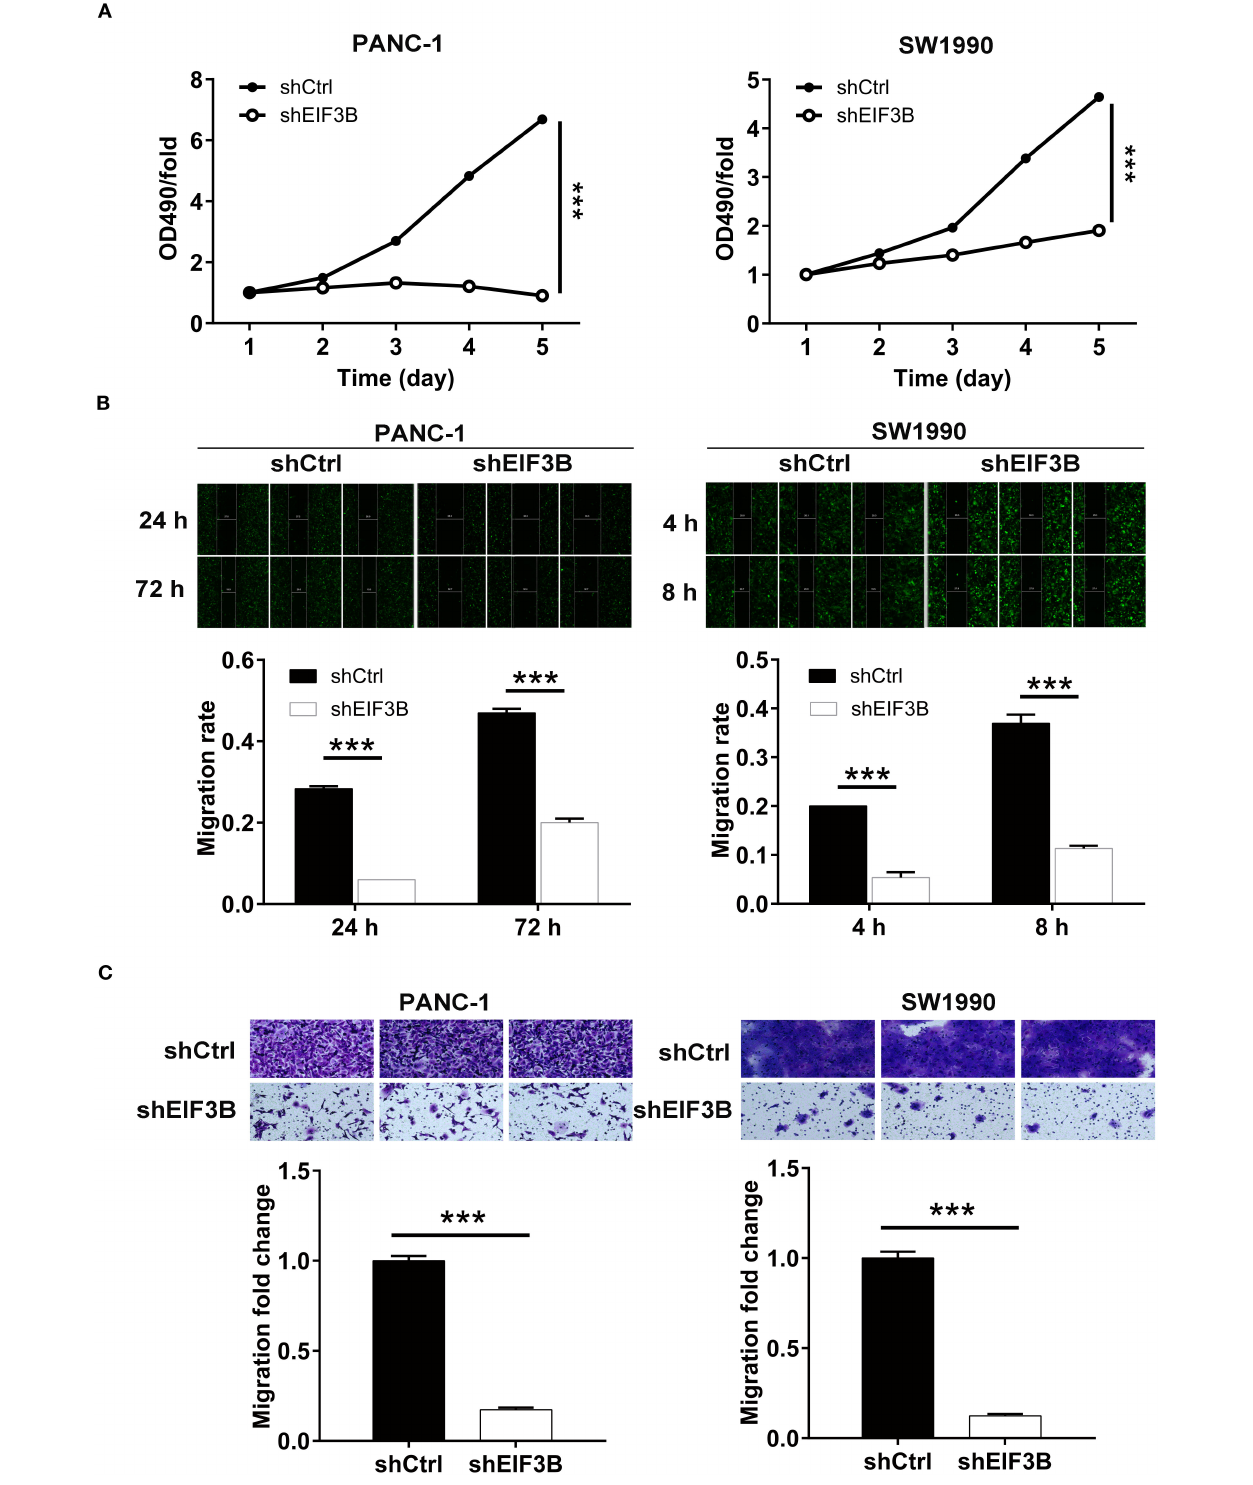
FIGURE 2 | Eukaryotic translation initiation factor 3 subunit B (EIF3B) knockdown inhibited cell proliferation and migration. (A) The cell proliferation rate was evaluated in pancreatic cancer (PC) cell lines after infection by MTT assay. (B) The migration rate of cells was detected in PC cell lines after infection by wound-healing assay. (C) The migration rate of cells was detected in PC cell lines after infection by transwell assay. Results are presented as mean ± SD. *** P < 0.001.